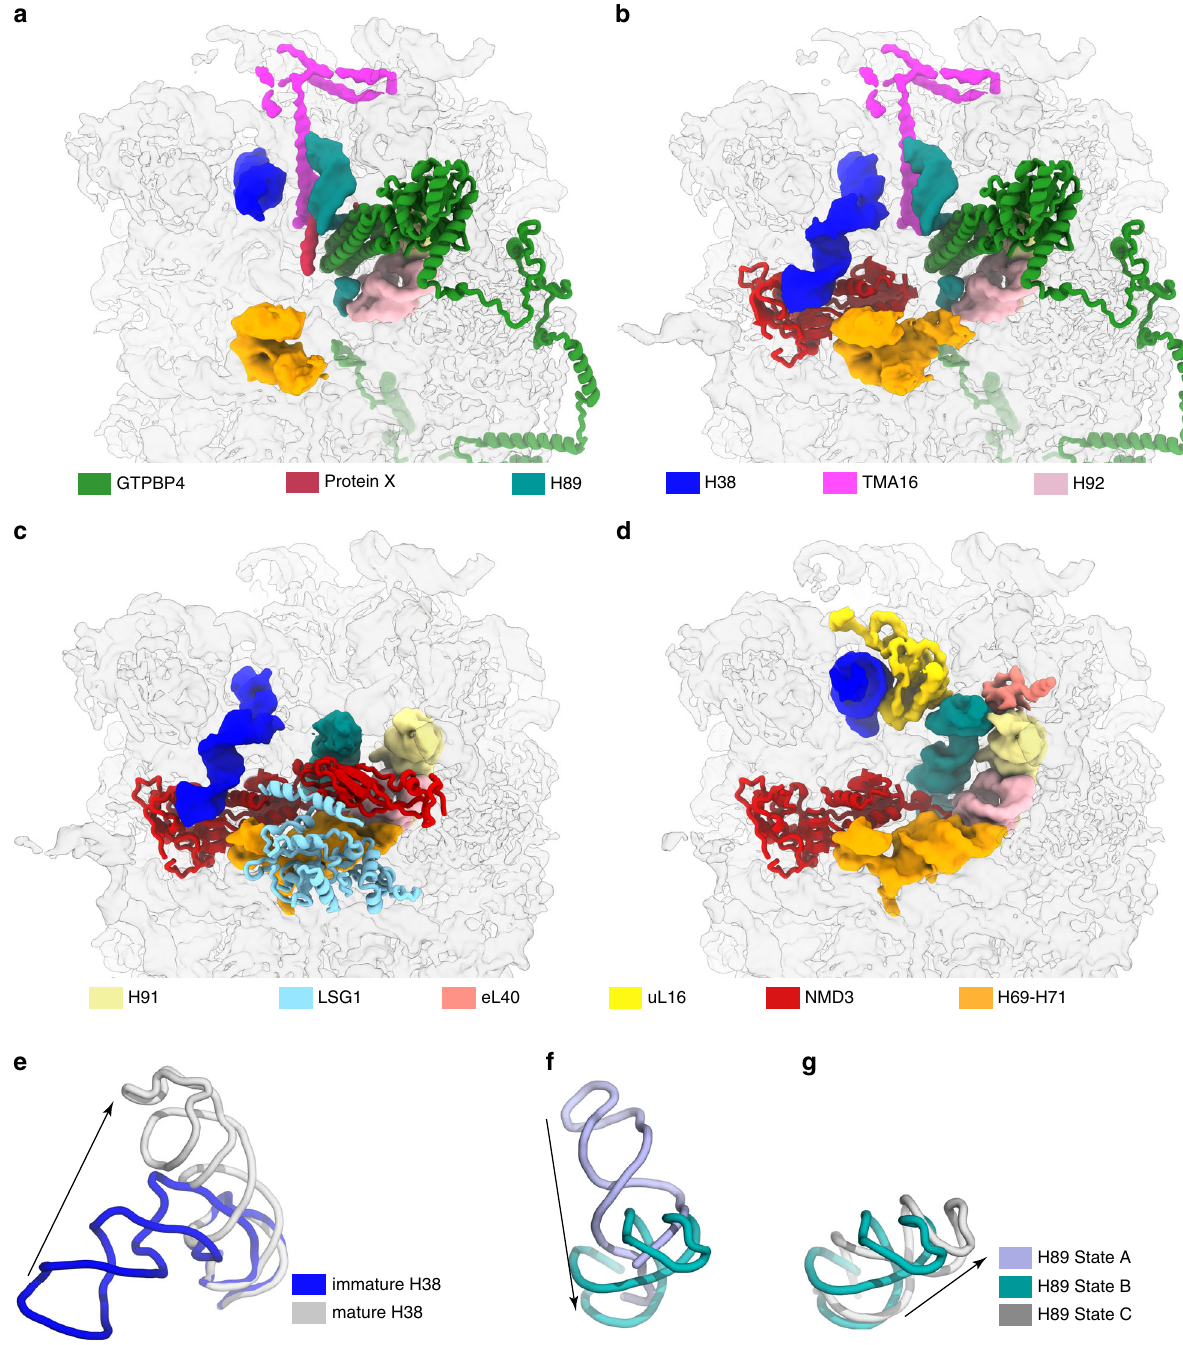
Fig. 4 Progressive maturation of the PTC in NMD3-particles. a-d Conformational changes of the PTC components from state pre-A to state C. Changed components are highlighted in different colors (H38, H89, H92, H91, H69-H71, uL16 and eL40) and the four maps are shown in transparent surface representation. The mode of NMD3-NTD in state B ( c ) was derived from the structure of yeast NMD3 (PDB 6RZZ) 23 . e Conformational change of H38 from the immature (blue) to mature state (gray). f , g Continuous conformational changes of H89 during the maturation of the